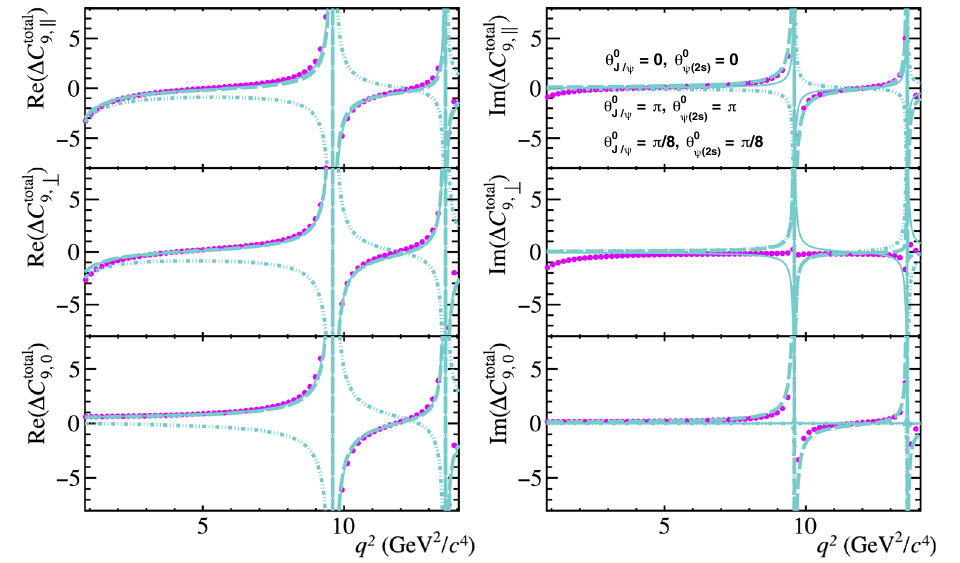
Fig. 2 The non-local contributions to the B 0 → K ∗ 0 μ + μ − transver- sity amplitudes as a function of q 2 . The real (left) and imaginary (right) components are shown separately. The prediction from Ref. [21] is shown (magenta points). Predictions using the model discussed in